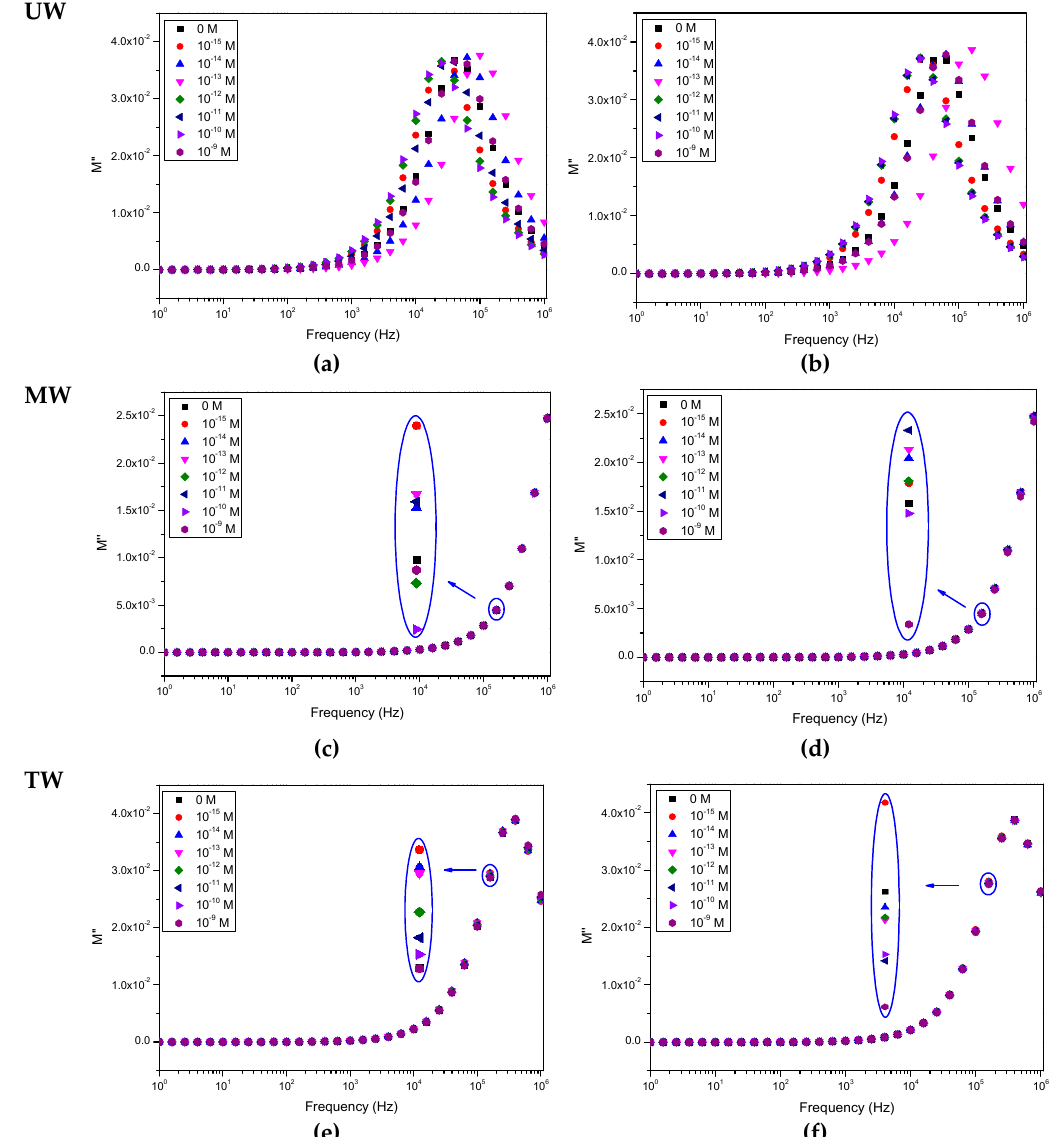
Figure 4. Spectra of the imaginary part of the electrical modulus (M’’) of the sensor devices when immersed in water solutions spiked with different EE2 concentrations: ( a ) uncoated IDE in UW, ( b ) IDE coated with (PEI/PSS) 5 film in UW, ( c ) uncoated IDE in MW, ( d ) IDE coated with (PEI/PSS) 5 film in MW, ( e ) uncoated IDE in TW, ( f ) IDE coated with (PEI/PSS) 5 film in TW. Relative error is less than 1%.